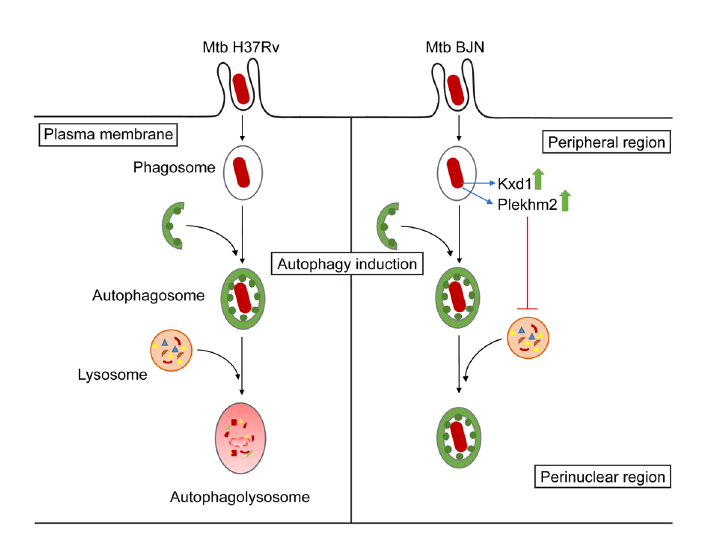
Figure 7. Schematic representation of induced lysosome repositioning as an escape mechanism from starvation-induced autophagic restriction by the BJN strain. Autophagy induction by starvation promotes M. tuberculosis reference strain H37Rv elimination in the autophagolysosome. The BJN strain, on the other hand, can upregulate the expression of Kxd1 and Plekhm2 resulting in the suppression of lysosome positioning towards the perinuclear region during autophagy induction by starvation, thus sparing its phagosome from autophagy-mediated lysosomal delivery and